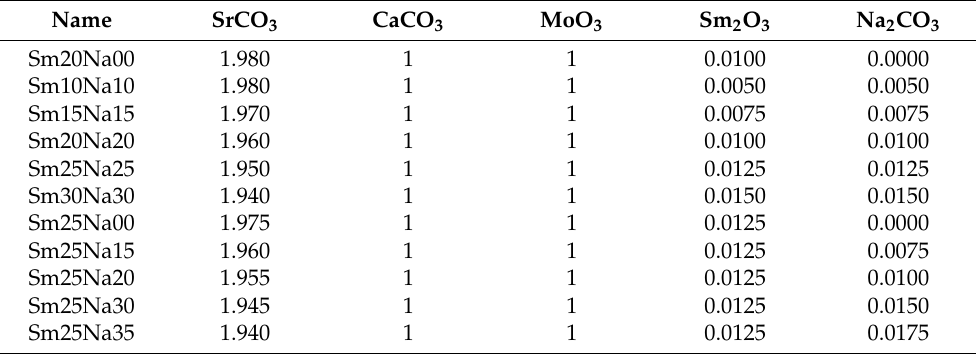
Sr 2 CaMoO 6 :Sm,Na phosphors